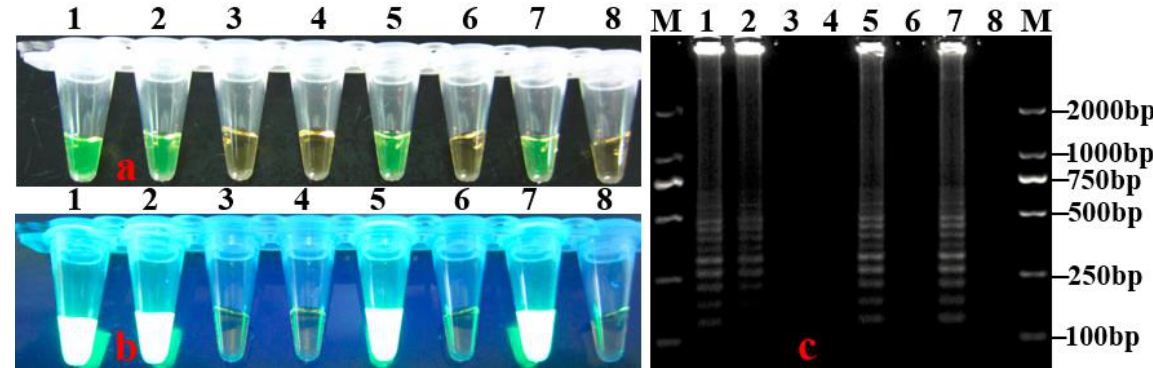
Figure 6. Ability of the LAMP assay to detect M. acerina in Sanqi leaves. ( a ) LAMP products were visualized by naked eye under natural light (color change, yellow-green indicate positive reaction). ( b ) LAMP products were visualized by naked eye under UV light (bright white turbidity indicates positive reaction). ( c ) LAMP products were analyzed using electrophoresis on 2% agarose gel (ladder-like pattern bands indicate positive reaction). Lane M: DL 2000 marker; Lane 1: Positive control ( M. acerina genomic DNA); Lane 2–4, 6: Asymptomatic leaves; Lane 5, 7: Leaves with symptoms of round spot disease; Lane 8: Negative control (sterile distilled water). The color of tubes 1, 2, 5, and 7 is yellow-green.